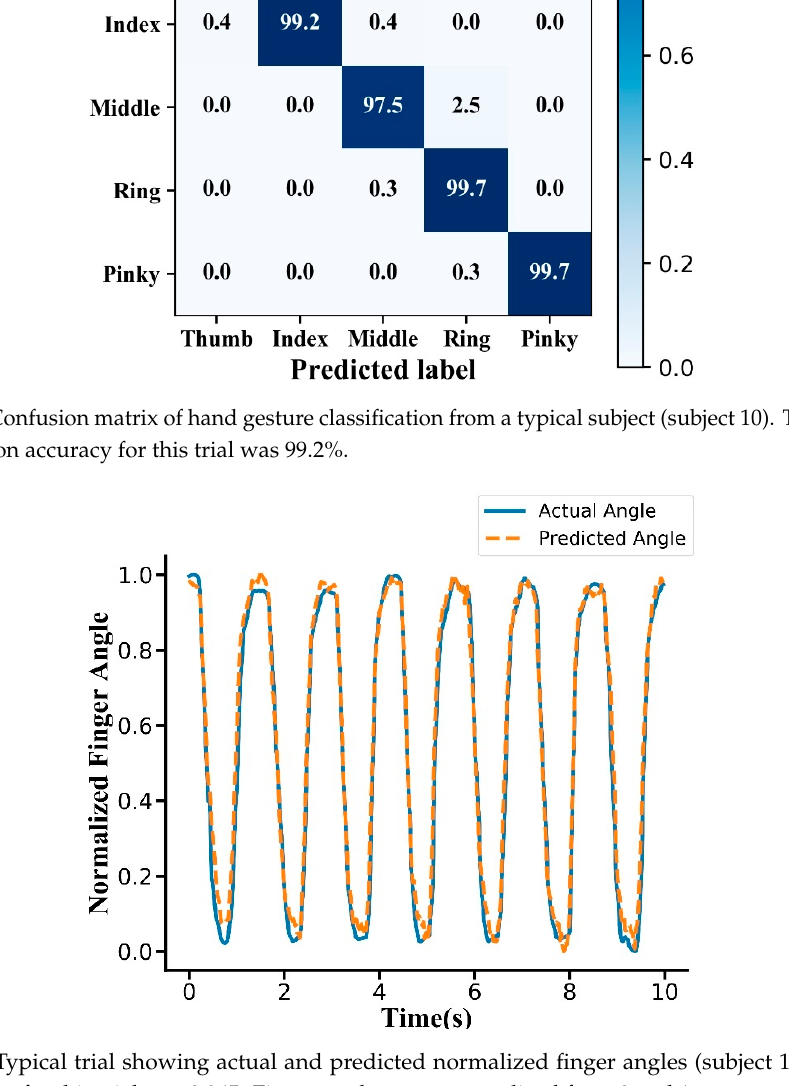
(b) Figure 6. Overall results for different models: CNN_Aug (presented model) = convolutional neural network with data augmentation, CNN = convolutional neural network without data augmentation,